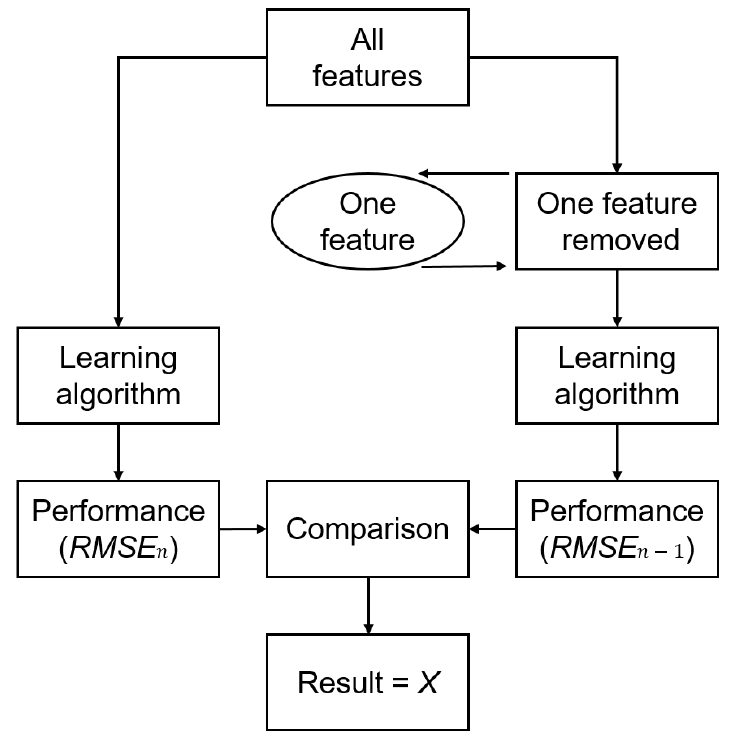
Figure 7. The flowchart of the applied wrapper method (AWM) for the importance analysis of explanatory variables in the LSTM model.